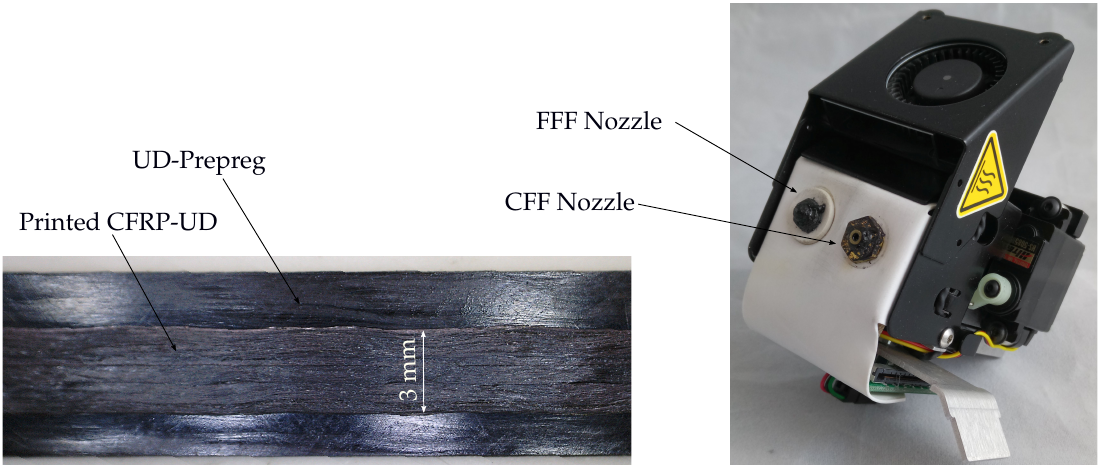
Figure 6. Printed unidirectional carbon-fiber-reinforced plastic (CFRP-UD) on UD-Prepreg with Markforged 3D printer head; FFF (Fused Filament Fabrication), CFF (Continuous Filament Fabrication).